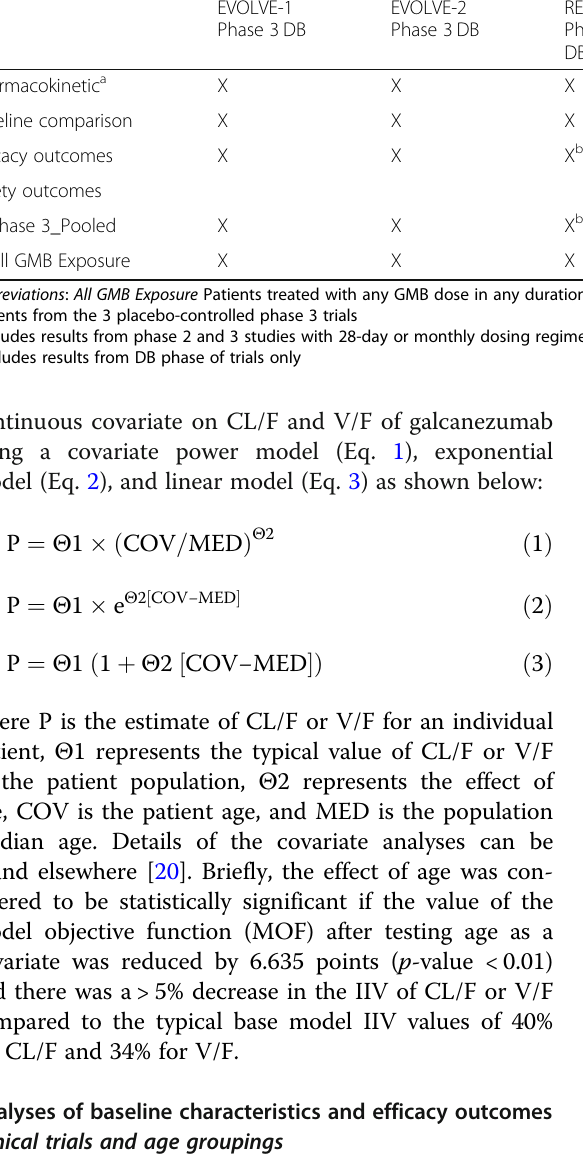
Table 2 Clinical trial populations included in analyses